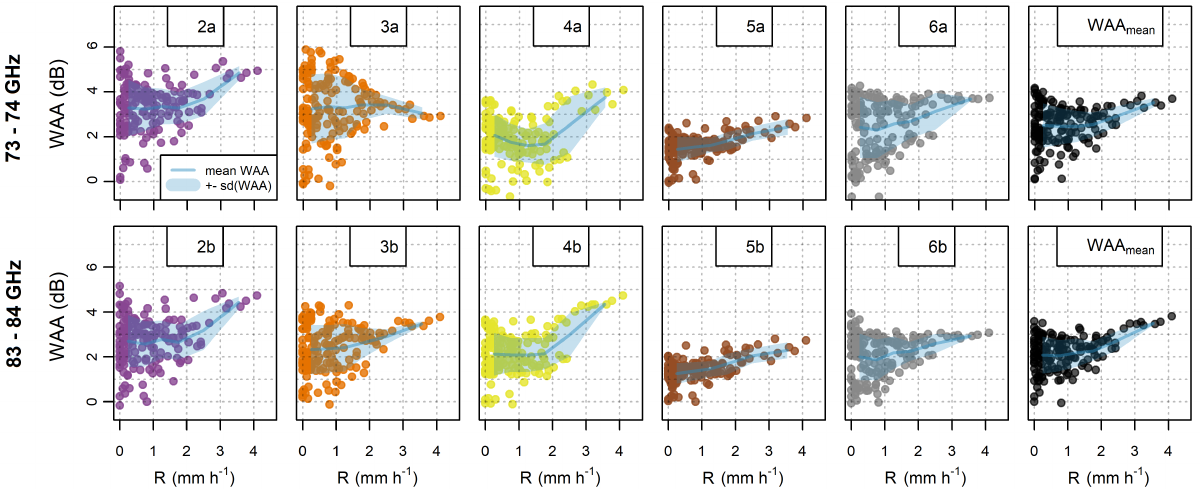
Figure 6. Wet antenna attenuation during rainfall estimated from the differential attenuation of short and long CMLs. WAAs with their mean and standard deviation are shown for both sublinks (73–74 and 83–84GHz) of CMLs 1–5. The panels on the right side show mean WAA for all